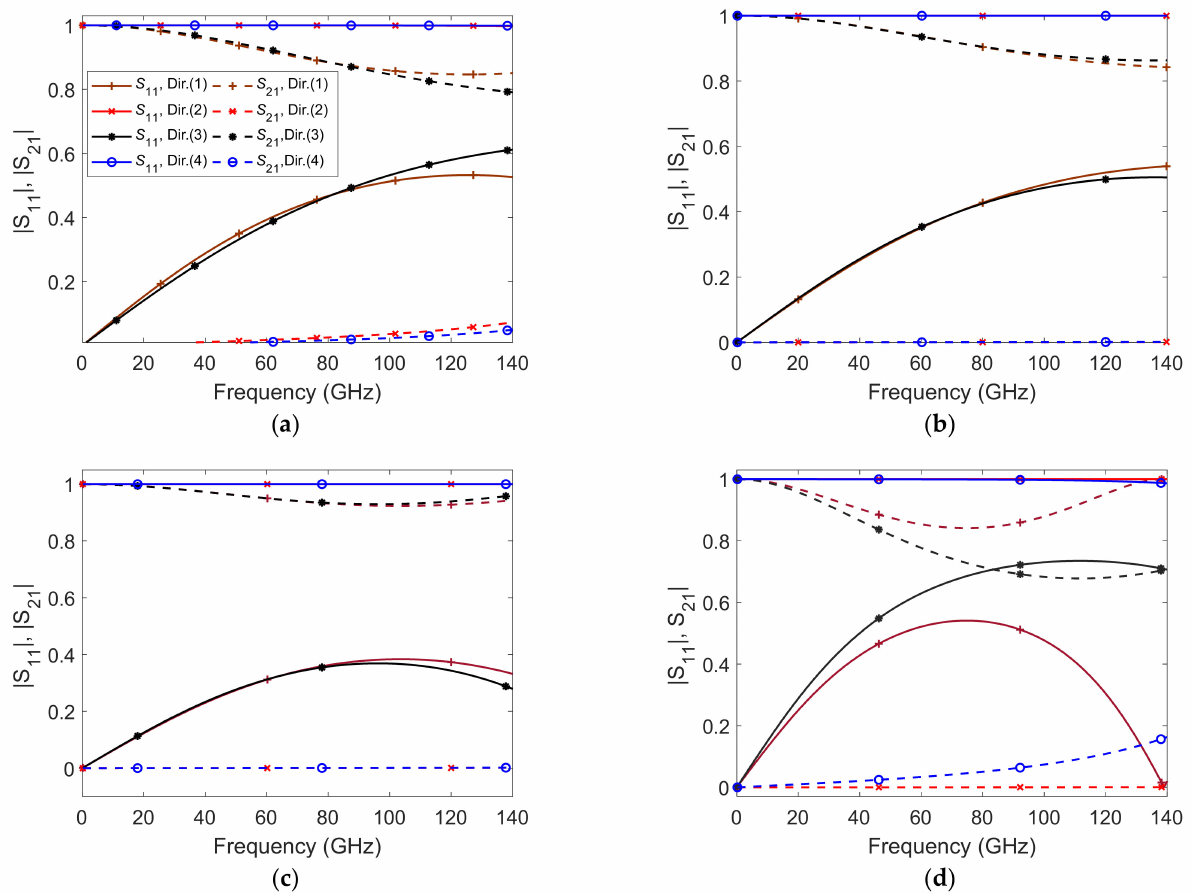
Figure 2. Scattering parameters of the unit-cells A , B , C and D at four propagation directions. ( a ) Unit cell A , ( b ) unit cell B , ( c ) unit cell C , and ( d ) unit cell D